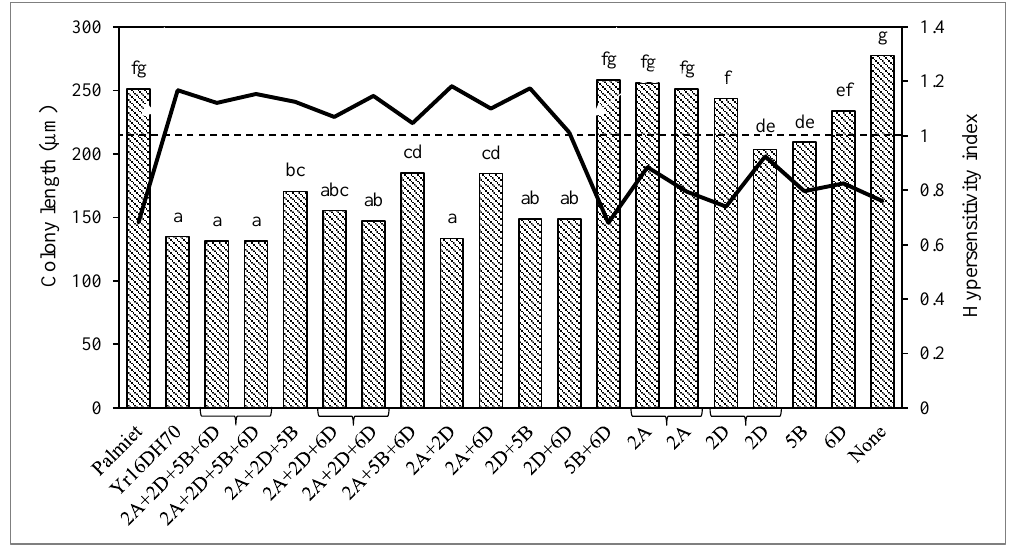
Figure 2. Average Puccinia striiformis f. sp. tritici race 6E22A+ colony lengths (pattern bars) and hypersensitivity indexes (HI; solid line) of recombinant inbred wheat lines with different combinations of the stripe rust resistance quantitative trait loci (QTL) 2A = QYr.ufs-2A , 2D = QYr.ufs-2D , 5B = QYr.ufs-5B and 6D = QYr.ufs-6D . Lines with HI values above the dotted line represent QTL combinations associated with host cell necrosis. Brackets indicate lines with matching predicted QTL profiles. Least significant differences (LSD) among lines for colony length and HI were calculated as 32.2 and 0.24, respectively, i.e., means with the same letter do not differ significantly from each other ( p ≤ 0.01).